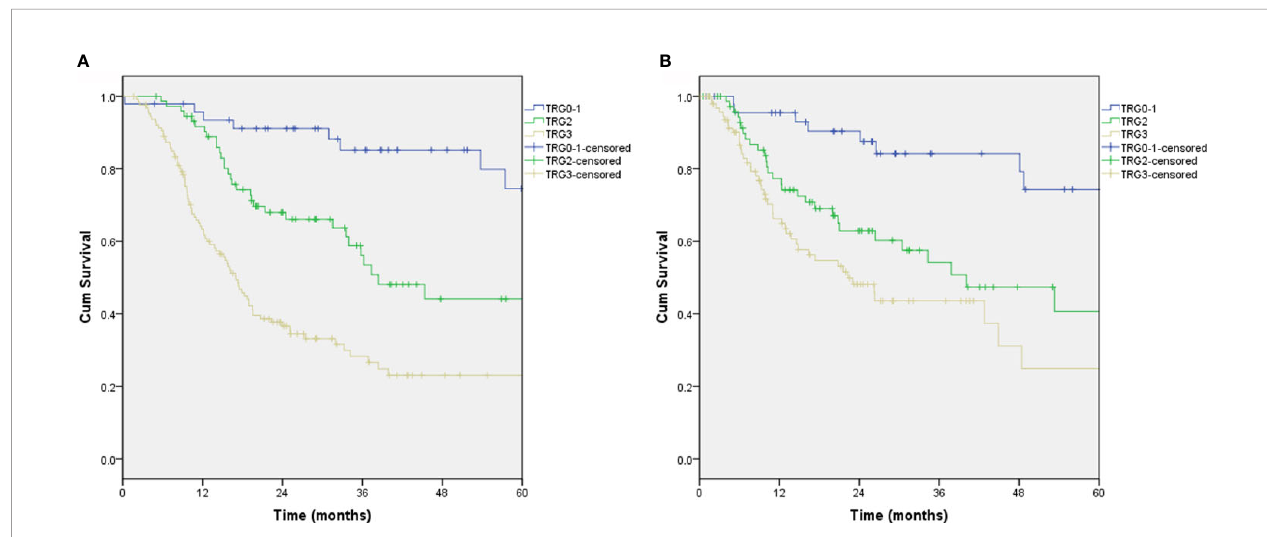
FIGURE 1 | Overall survival and recurrence-free survival from TRG scores. (A) Overall survival, P<0.001; (B) Recurrence-free survival,